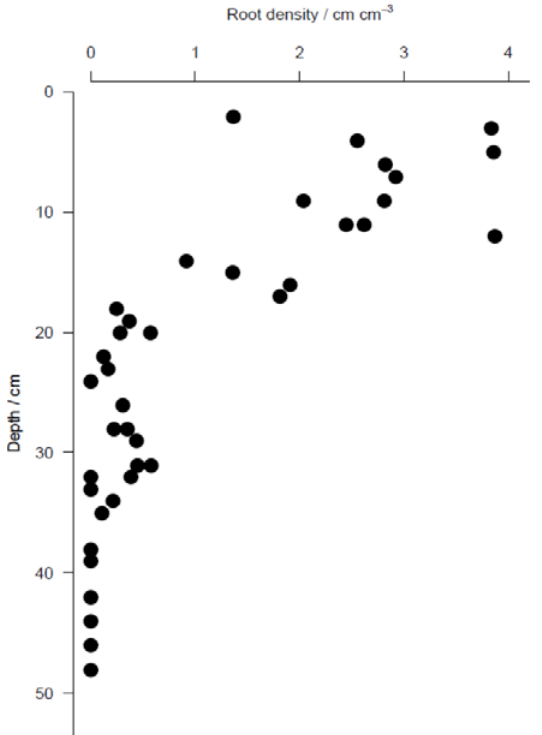
Figure 12. Profile of root density.